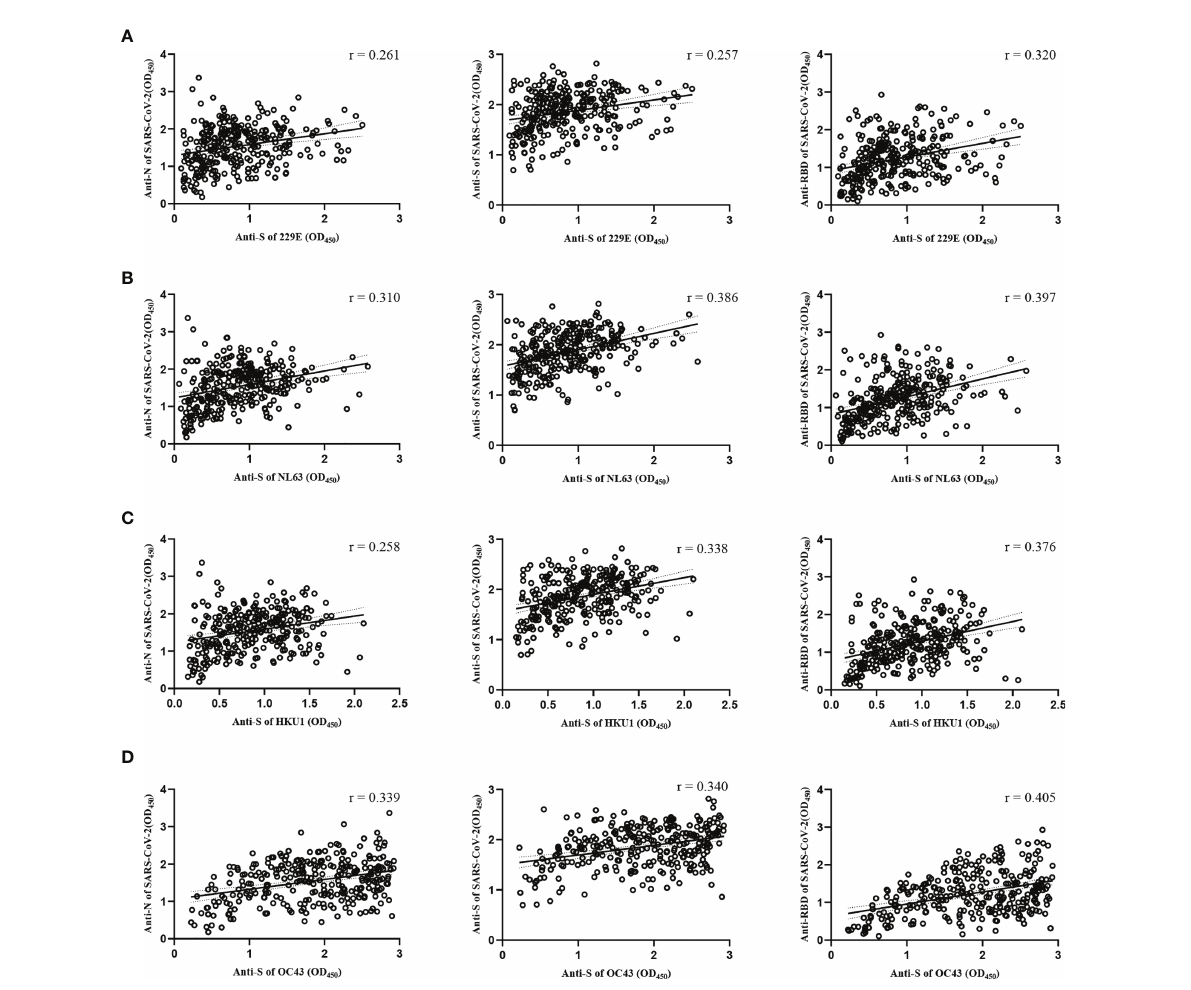
FIGURE 5 Correlations between the S-speci fi c IgG antibodies against LPH-CoVs and the cross-reactive antigens-speci fi c IgG antibodies against SARS- CoV-2 for the serum samples with only one of the LPH-CoVs exposure (n=298) (A-D) The correlations between the S-speci fi c IgG antibodies against HCoV-229E (A) , HCoV-NL63 (B) , HCoV-HKU1 (C) , HCoV-OC43 (D) and the cross-reactive IgG antibodies against the N, S, RBD antigens of SARS-CoV-2 were assessed by Pearson correlation test. The r values were exhibited for the correlation. A two-tailed P value<0.05 was considered statistically signi fi